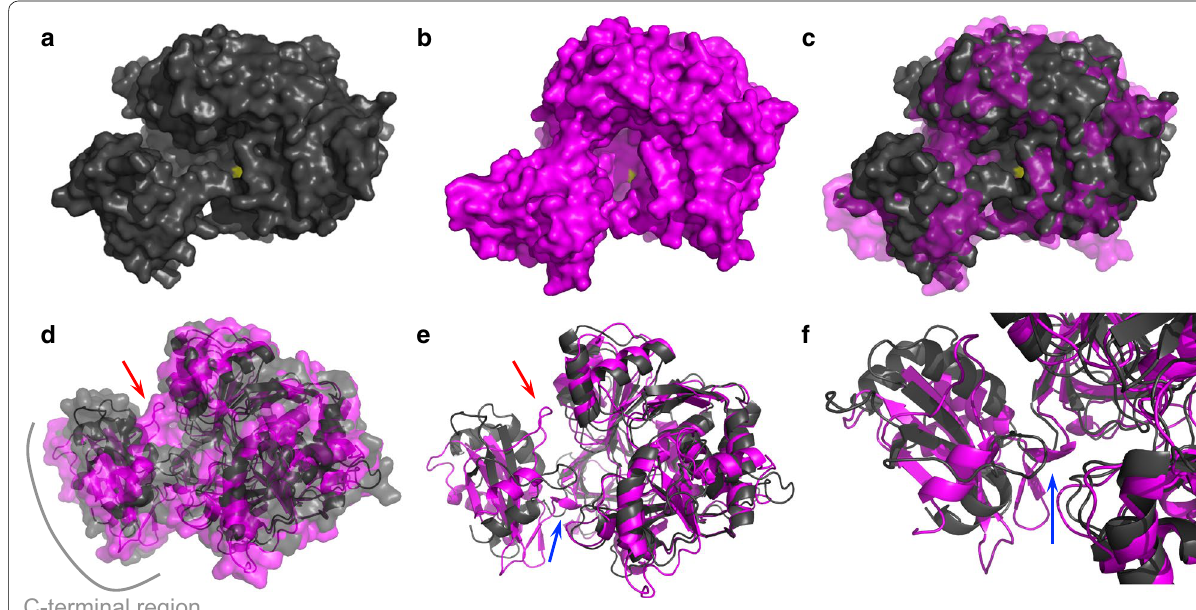
Fig. 4 Modeled structures of LvaE2 from LA18T (black) and LvaE from KT2440 (magenta). Molecular surfaces ( a – d ) and structural models ( d – f ) were superimposed using PyMOL and the structures around the active site were compared. Red arrows indicate the predicted loop structure near the active site of LvaE. Blue arrows indicate the linker regions of LvaE and LvaE2. The location of the active site is shown in yellow ( a – c